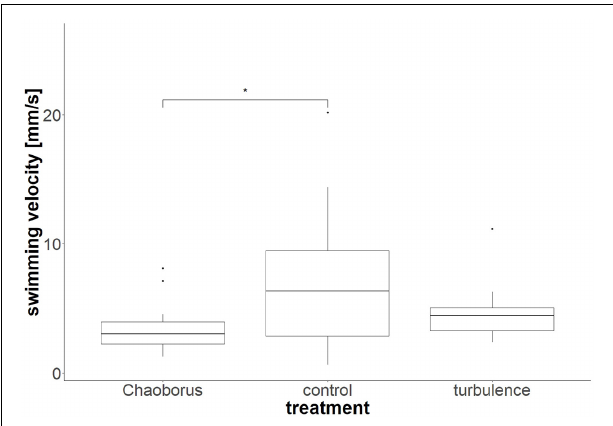
FIGURE 1 | Swimming velocities of D. cucullata . Depicted are the swimming velocities of the typical morph, the morph in the presence of Chaoborus , as well as in the presence of turbulence. * p < 0.05.